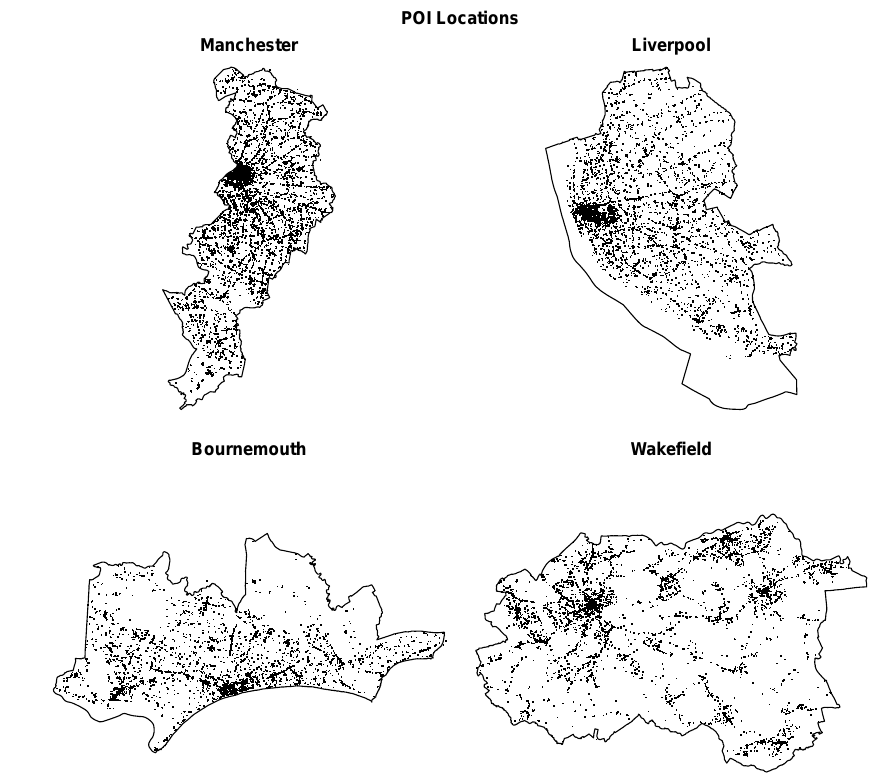
Figure 4. Point of interest (POI) locations within each urban area.